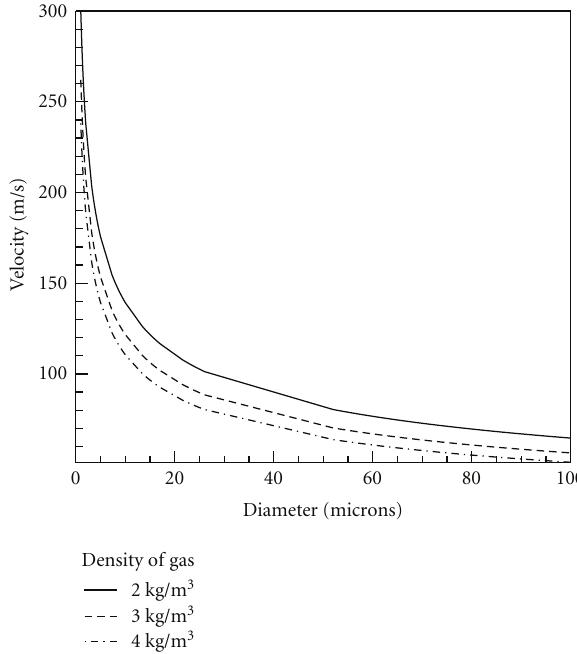
Figure 2: Critical velocity versus particle diameter for various gas